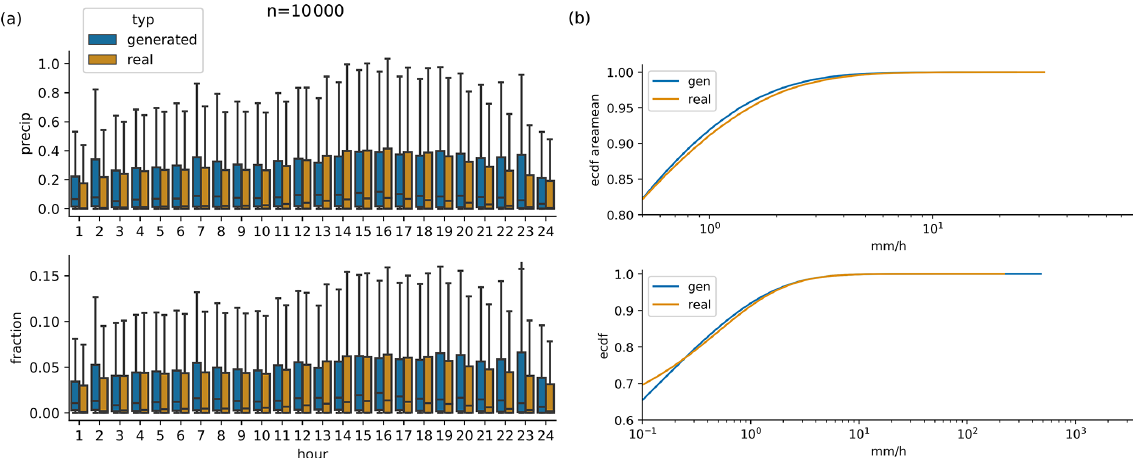
Figure 7. (a) Daily cycle of 10000 randomly selected real observations, and scenarios generated by conditioning on exactly the same 10000 daily sums. (b) Cumulative distribution functions of generated and observed hourly area mean precipitation (upper panel) and hourly point-level precipitation (lower panel), same data as in (a)